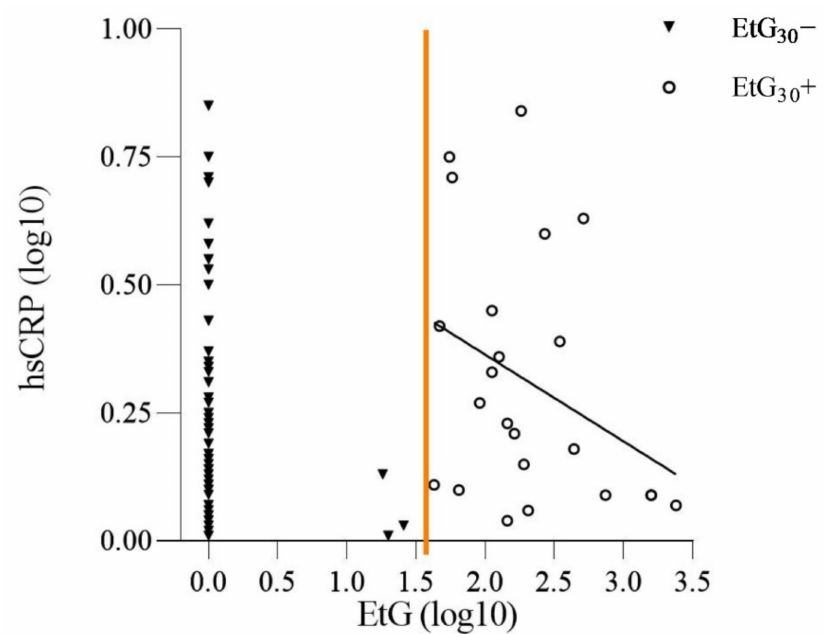
Figure 3. Dose–Response Relation of EtG Values and hsCRP Levels. Distribution of the adolescents’ log-transformed (log10) high-sensitivity CRP (hsCRP) and their log transformed (log10) meconium ethyl glucuronide (EtG); EtG 30 +/EtG 30 − value at birth. Partialcorrelation of hsCRP levels and EtG values within the EtG 30 + group ( n = 23; r = − 0.35, p = 0.113). Regression line depicts inverse dose–response relation of hsCRP levels and EtG values. Orange line indicates split between EtG 30 − and EtG 30